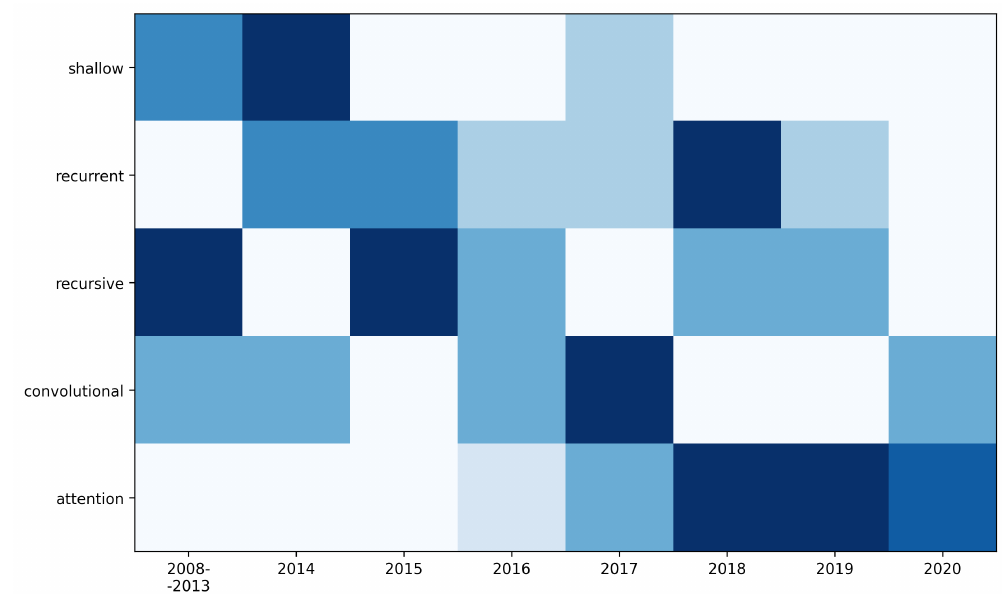
Figure A2. Number of models categorized by the main architecture and year. Values are normalized by rows. Higher values are